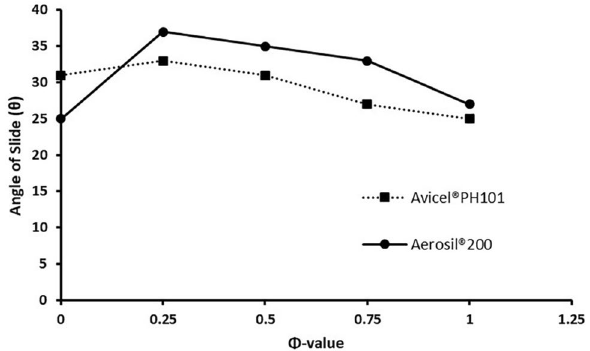
Figure 3. Angle of slide for admixtures of Avicel PH101 and Aerosil 200 SNEDDS as the liquid vehicle in different ratios.